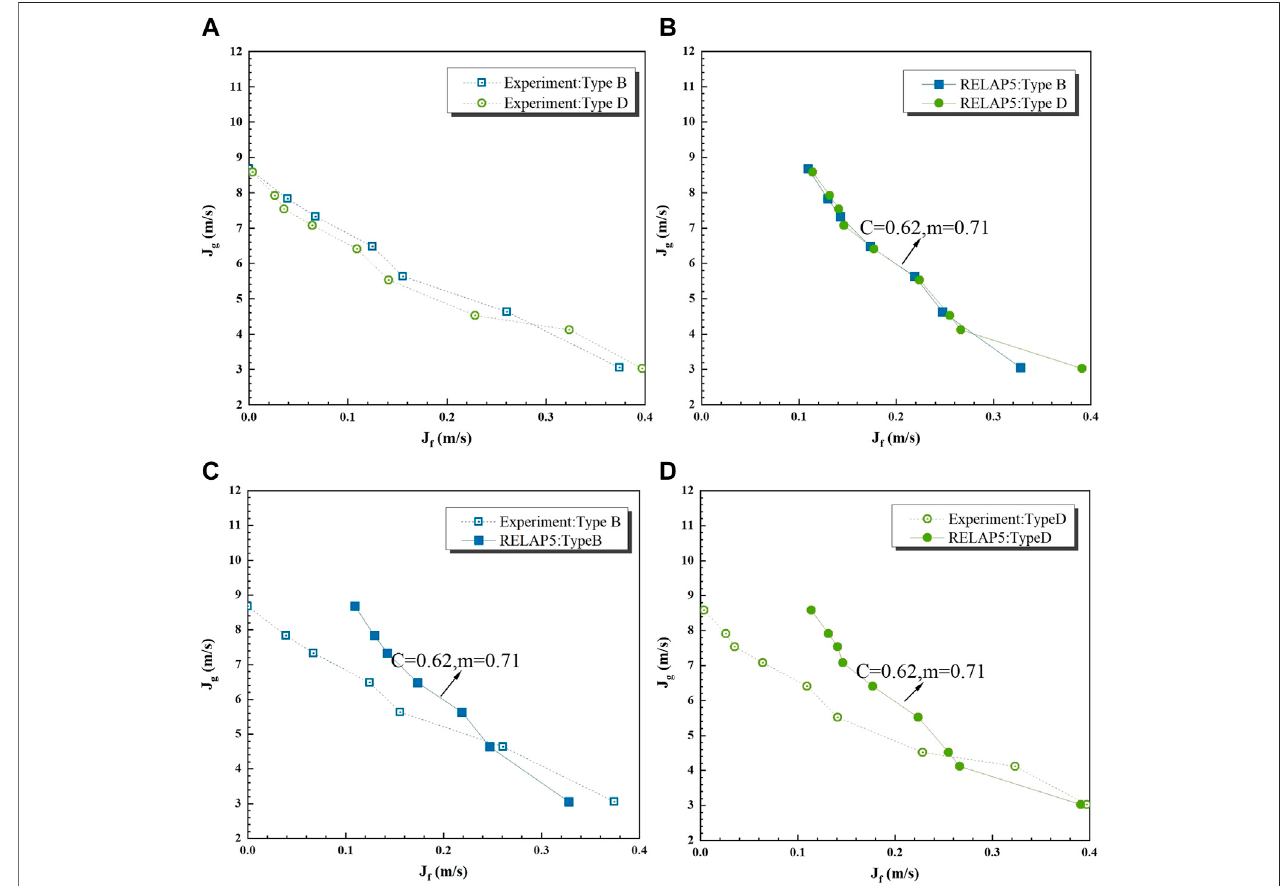
FIGURE 11 | Effect of blow